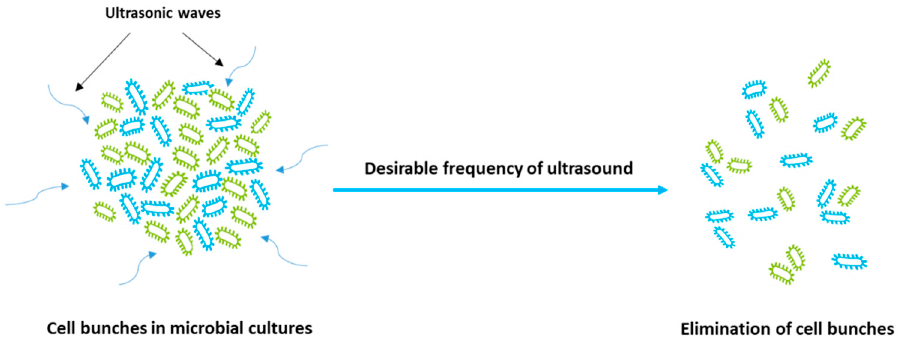
ff ect of ultrasonication on the elimination of microbial cell Figure 2. Effect of ultrasonication on the elimination of microbial cell bunches. Figure 2. E